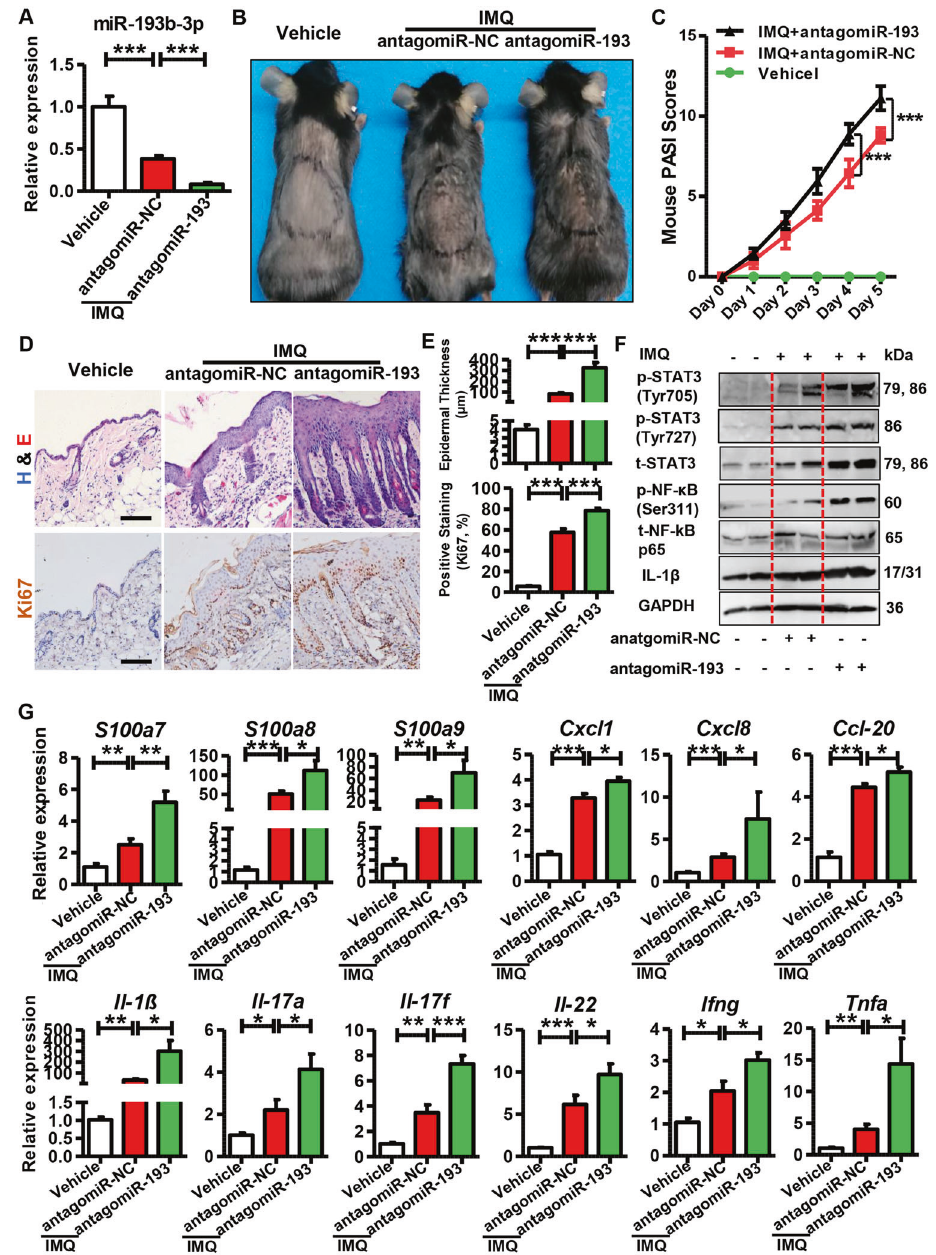
Fig. 4 Role of antagomiR-193b-3p in IMQ-induced psoriasis mouse model. A Expression levels of miR-193b-3p in mouse back skin of different groups. Vehicle means mice injected with antagomiR-NC and treated with Vaseline, antagomiR-NC + IMQ and antagomiR-193 + IMQ means mice injected with antagomiR-NC and antagomiR-193b-3p, respectively, and then treated with IMQ for 5 consecutive days. miR-193b-3p levels were analyzed using qRT-PCR. U6 was used as the internal control. Each bar represents mean ±SEM ( n = 8). *** P <0.001, compared with the indicated controls. B Representative pictures showing the mouse back skin lesions injectied withantagomiR-193/antagomiR-NC in the presence or obsence of IMQ treatment for 5 consecutive days. C PASI scores of mouse back skin lesions in different groups at different time points. PASI scores of mouse back skin lesions were recorded and analyzed daily. Each bar represents mean ±SEM ( n = 8). *** P <0.001, compared with the indicated controls. D Representative images showing histological feature of skin tissues derived from mouse back injected with antagomiR-193 or antagomiR-NC in the presence or absence of IMQ treatment for 5 consecutive days. Scar bar of upper panel: 100µm, scar bar of lower panel: 100µm. E Quanti fi cation data of skin epidermal thickness (upper panel, n = 8) and Ki67-positive cells (lower panel, n = 8) in skin tissues derived from mouse back injected with antagomiR-193 or antagomiR-NC in the presence or absence of IMQ treatment for 5 consecutive days. *** P <0.001, compared with the indicated controls. F Representative blots showing the levels of phospho-STAT3 (Tyr705), phospho-STAT3 (Ser727), phospho-NF- κ B p65 (Ser311), IL-1 β , etc. in skin tissues derived from mouse back injected with antagomiR-193 or antagomiR-NC in the presence or absence of IMQ treatment for 5 consecutive days. Tissues were collected at day 6 and protein levels were detected by western blotting. GAPDH was used as a protein loading control. G mRNA levels of psoriasis-related genes and in fl ammatory genes in skin tissues derived from mouse back injected with antagomiR-193 or antagomiR-NC in the presence or absence of IMQ treatment for 5 consecutive days. Skin tissues were collected at day 6 and mRNA levels were analyzed using qRT-PCR. GAPDH was used as the internal control. Each bar represents mean± SEM ( n = 8 for each group). *** P <0.001, ** P <0.01, * P <0.05 compared with the indicated controls.